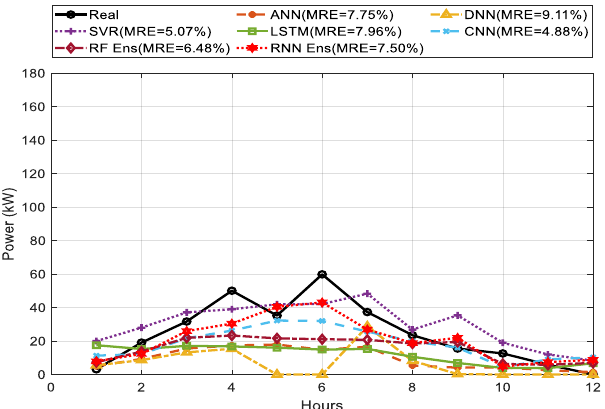
Figure 10. One-day ahead PV power forecasting results for sunny days between single model and Figure 11. One-day ahead PV power forecasting results for cloudy days between single model and Figure 11. One-day ahead PV power forecasting results for cloudy days between single model and Figure 11. One-day ahead PV power forecasting results for cloudy days between single model and ensemble model. ensemble model. ensemble model. ensemble model.